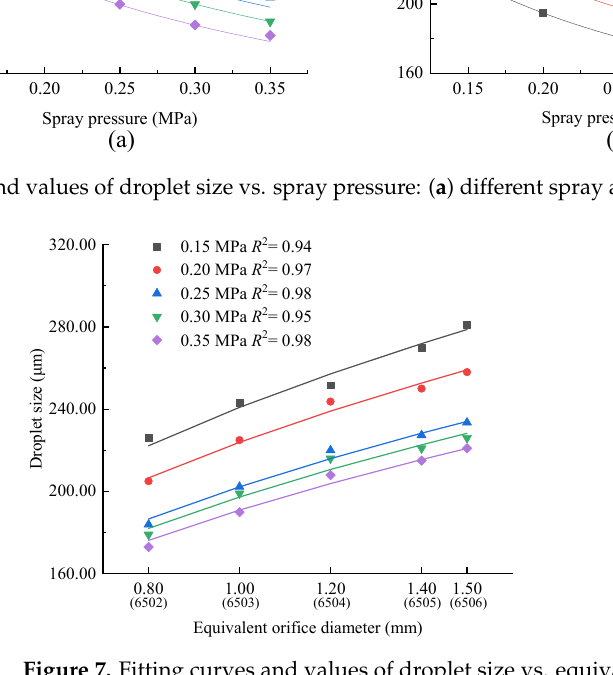
Figure 7. Fitting curves and values of droplet size vs. equivalent orifice diameter. The relationship between the spray angle and the droplet size at different pressure values with the same equivalent orifice diameter is shown in Figure 8. The droplet size along the Z-axis decreased with the increase in the spray angle. At constant spray pressure and flow rate, the increase in the spray angle was observed to lead to a decrease in the thickness of the liquid film after liquid ejection, with the thickness of the film was posi- tively correlated with the size of the droplet formed after breaking. Therefore, the larger the spray angle, the smaller the droplet size. The fitting function between the spray angle and the droplet size along the Z-axis is represented as follows: